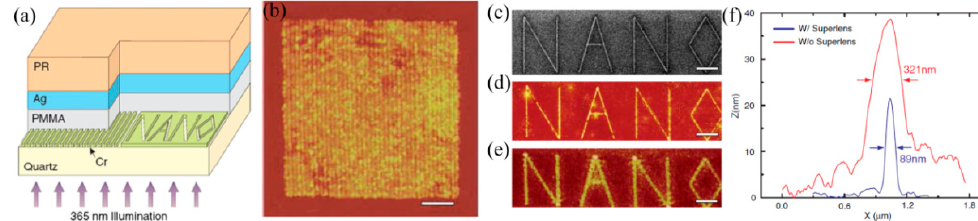
Figure 24. ( a ) Schematic of Ag superlens for plasmonic imaging lithography; ( b ) AFM image for 60nm half-pitch feature through Ag superlens (scale bar, 1mm); ( c ) The ‘‘NANO’’ object on the Cr film; AFM of the developed image on photoresist ( d ) with or ( e ) without a Ag superlens; ( f ) Cross section of